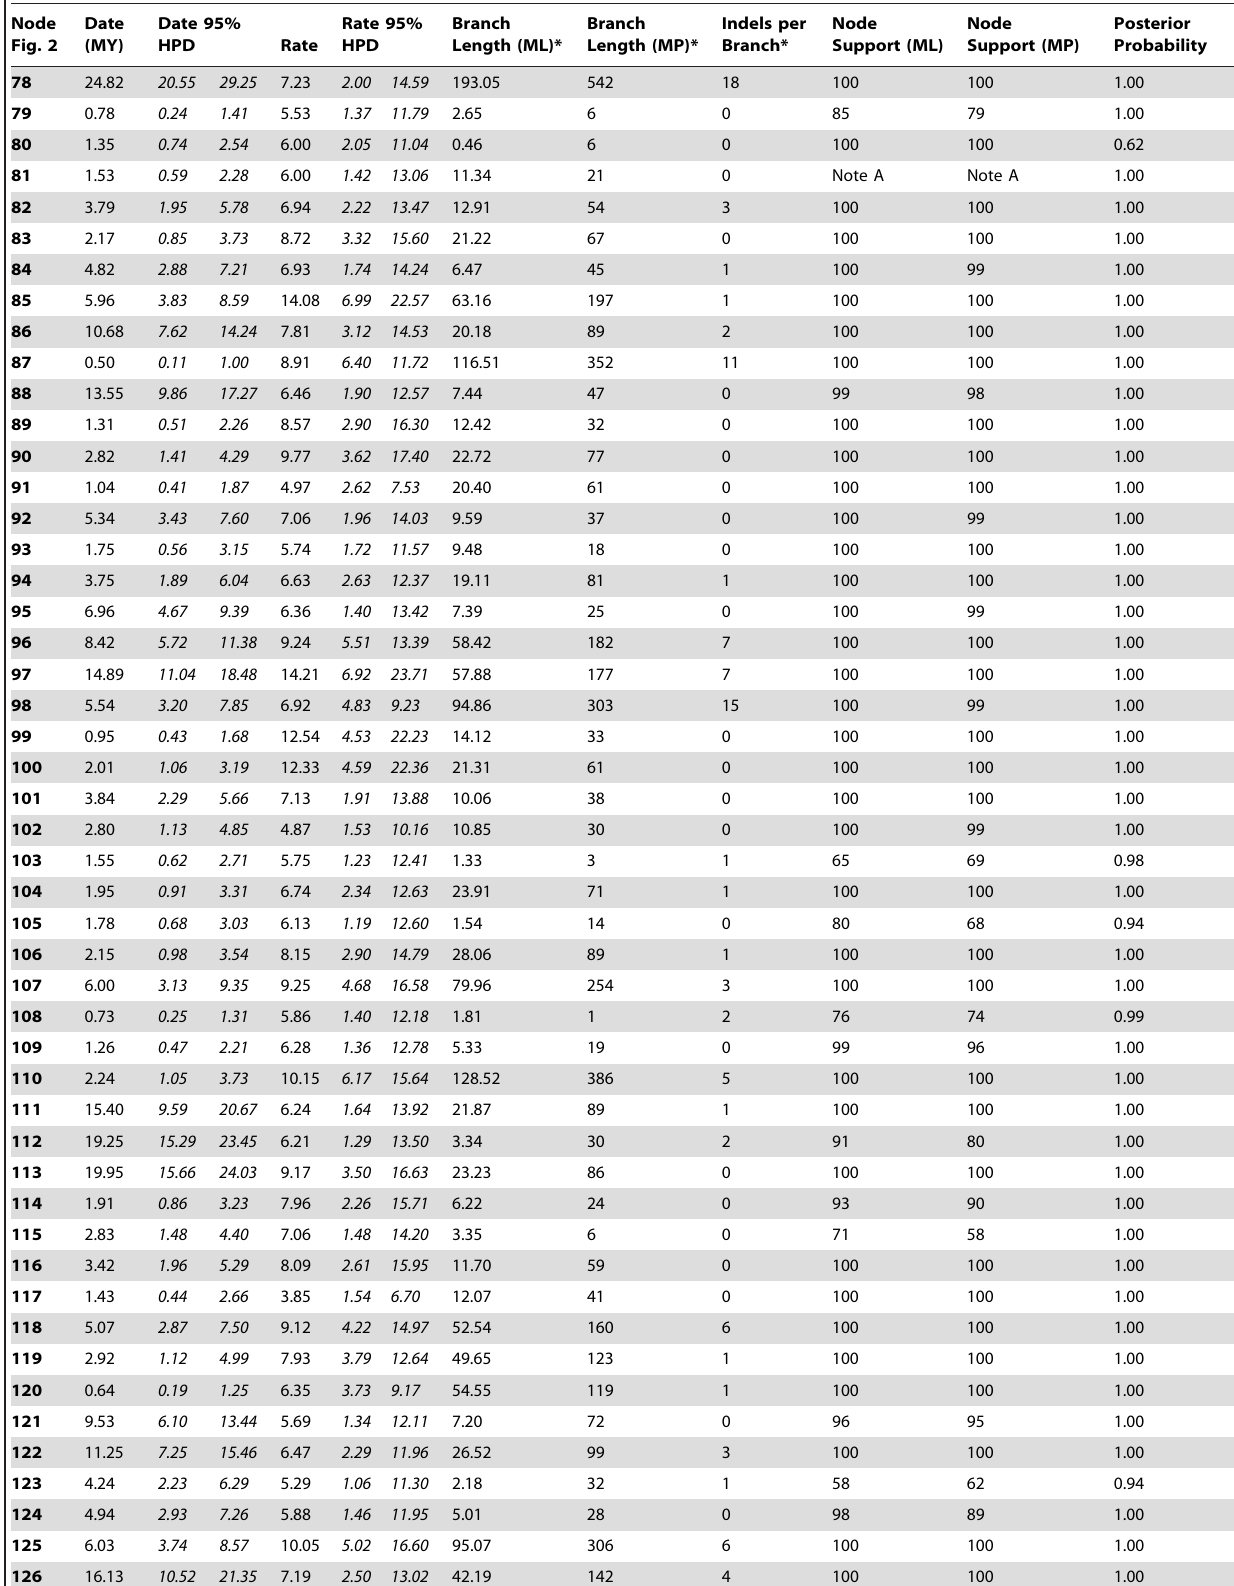
Table 2. Node Support, Branch Lengths, Divergence Times, and Nucleotide Substitution Rates for Platyrrhini in Figure 2.